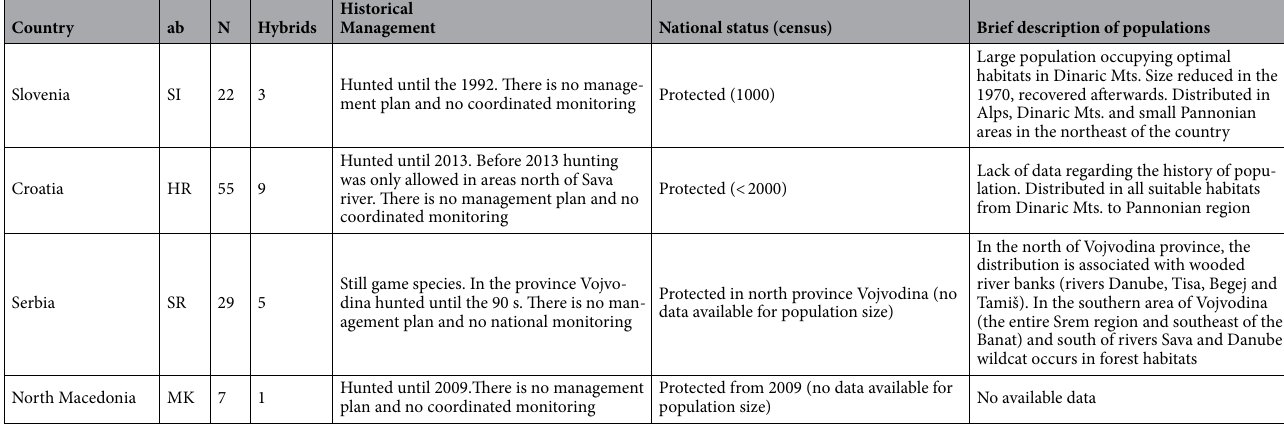
Table 4. Location, sample size, number of detected hybrids and brief history of European wildcat populations inhabiting the area between the Dinaric Alps and the Scardo-Pindic